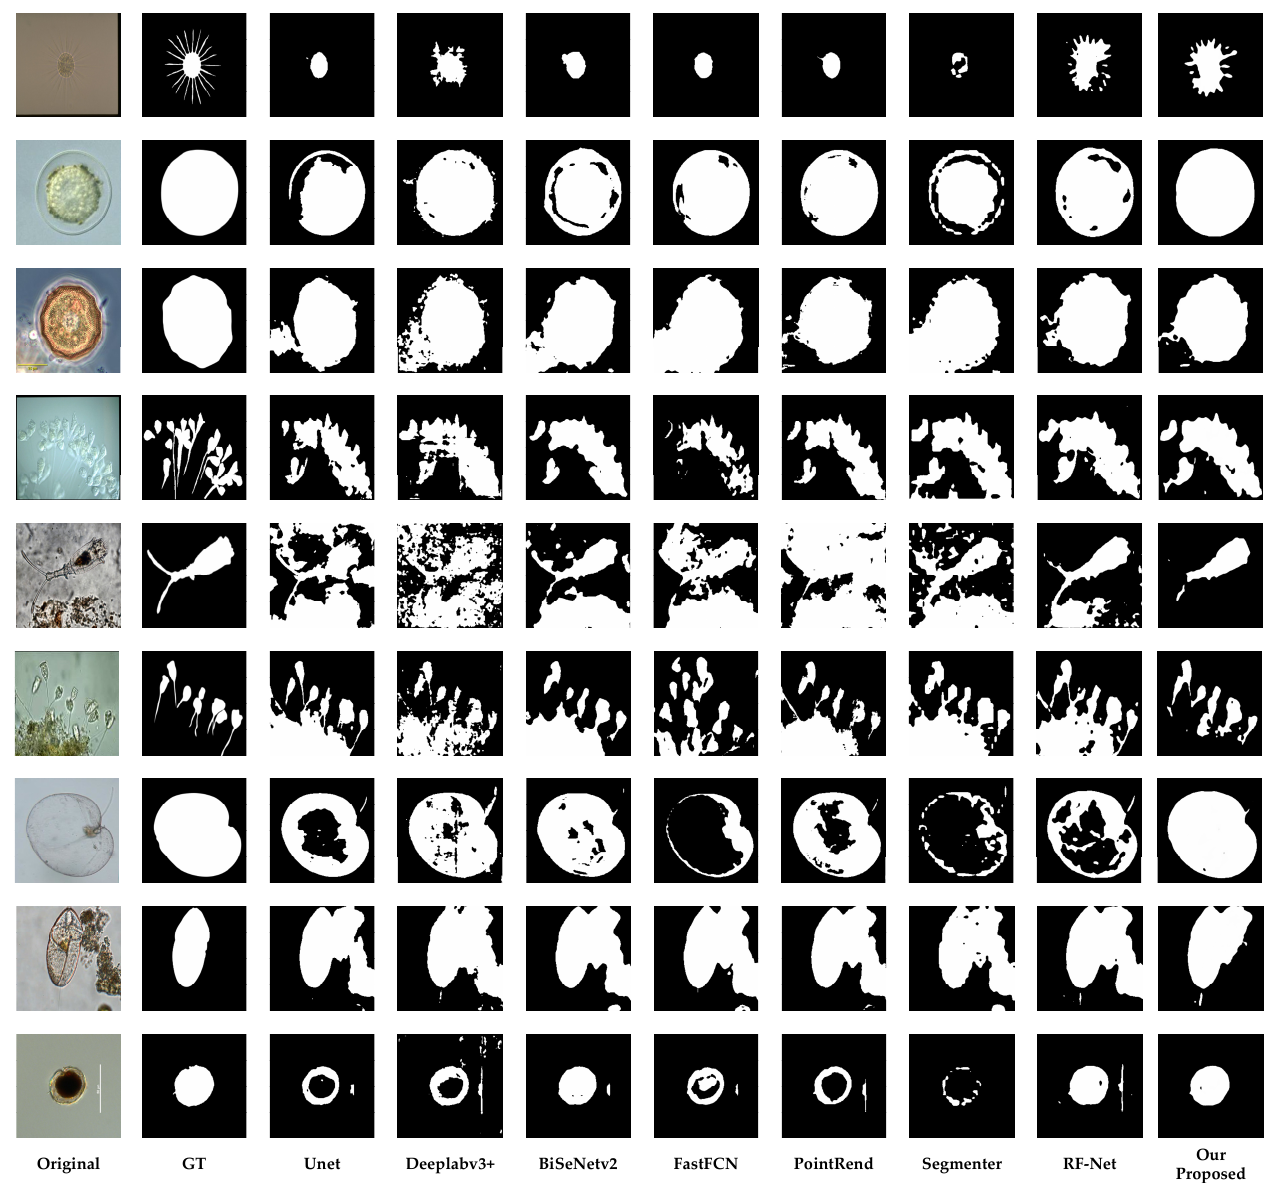
Figure 7. Visual comparison of different networks.